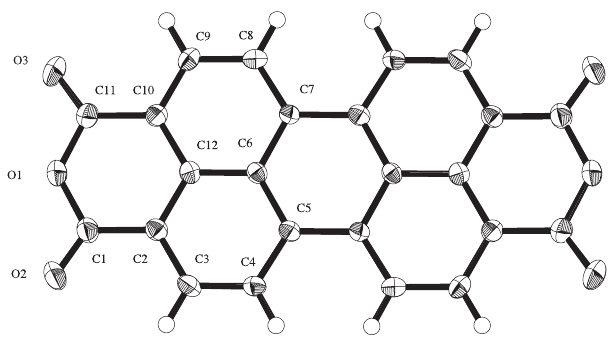
Table 1. Data collection and handling.